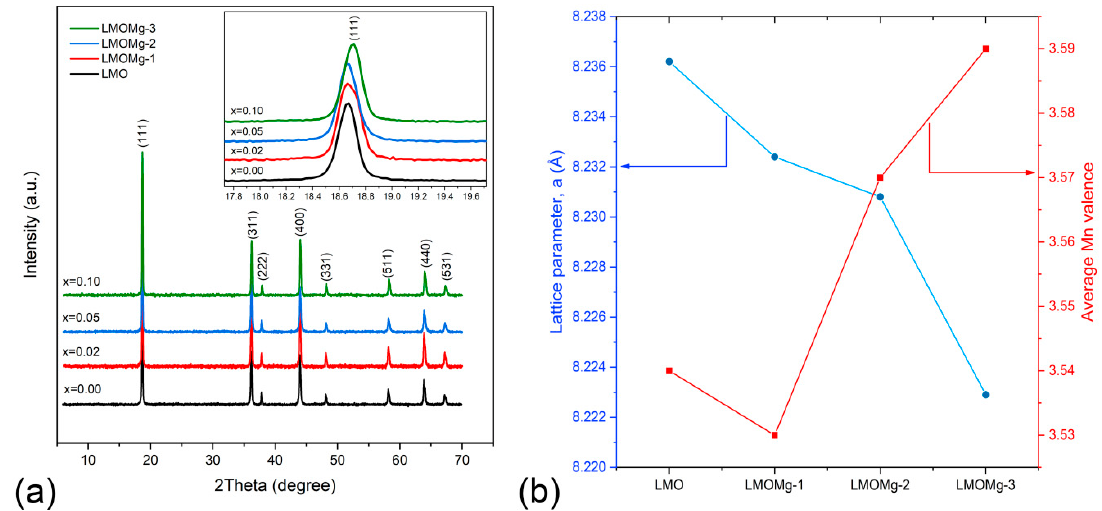
Figure 6. ( a ) LiMg x Mn 2 − x O 4 (x = 0.00, 0.02, 0.05, 0.10) nanometer powders’ diffraction patterns. Inset shows displacement of peak (111) towards higher angles with increase of x. ( b ) Decrease of cell parameter “a” and raised average Mn valence with increasing doping concentration of Mg.